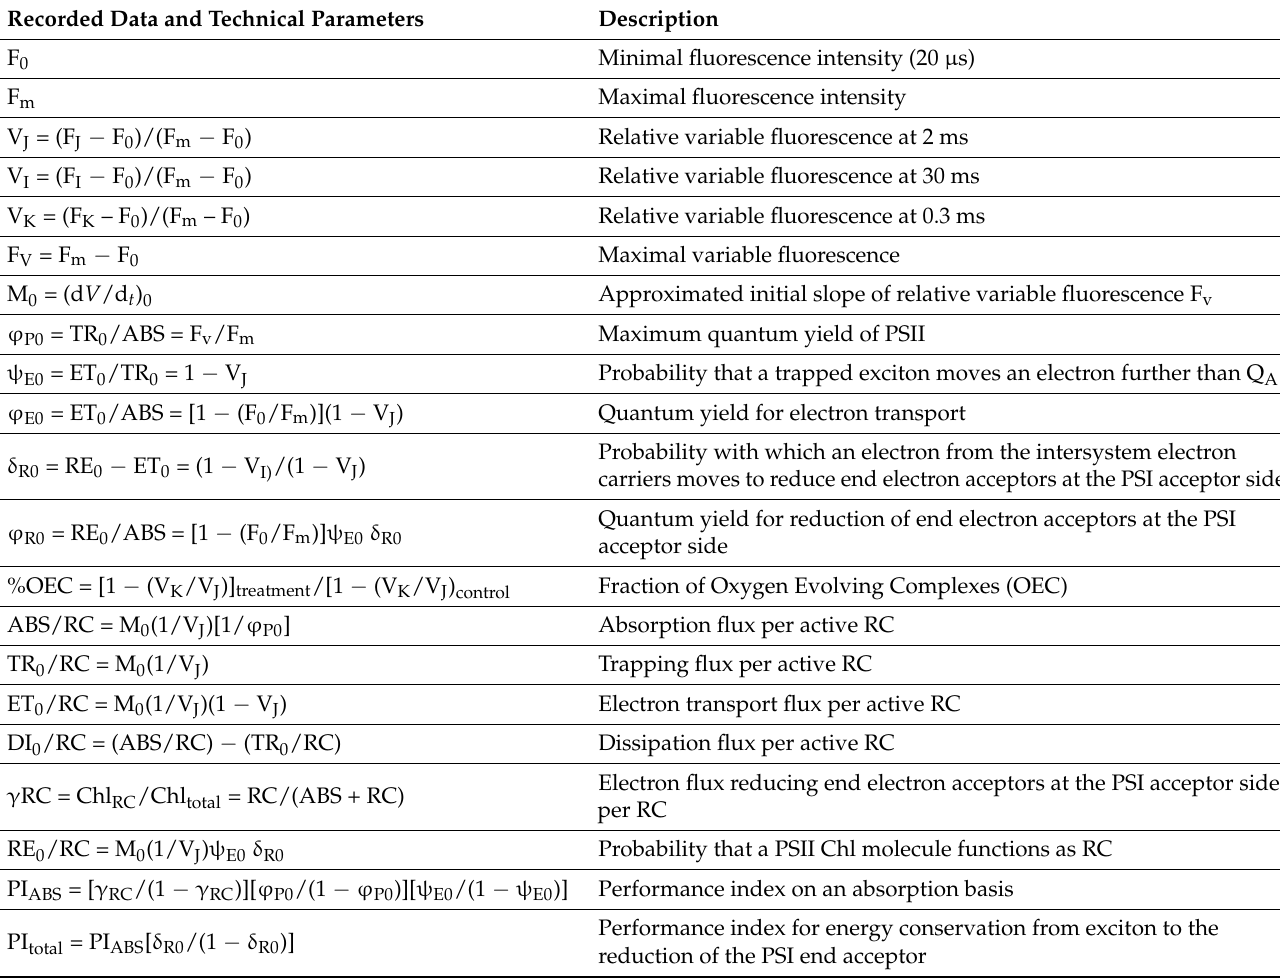
Table 3. Calculations and definitions of selected JIP-test parameters